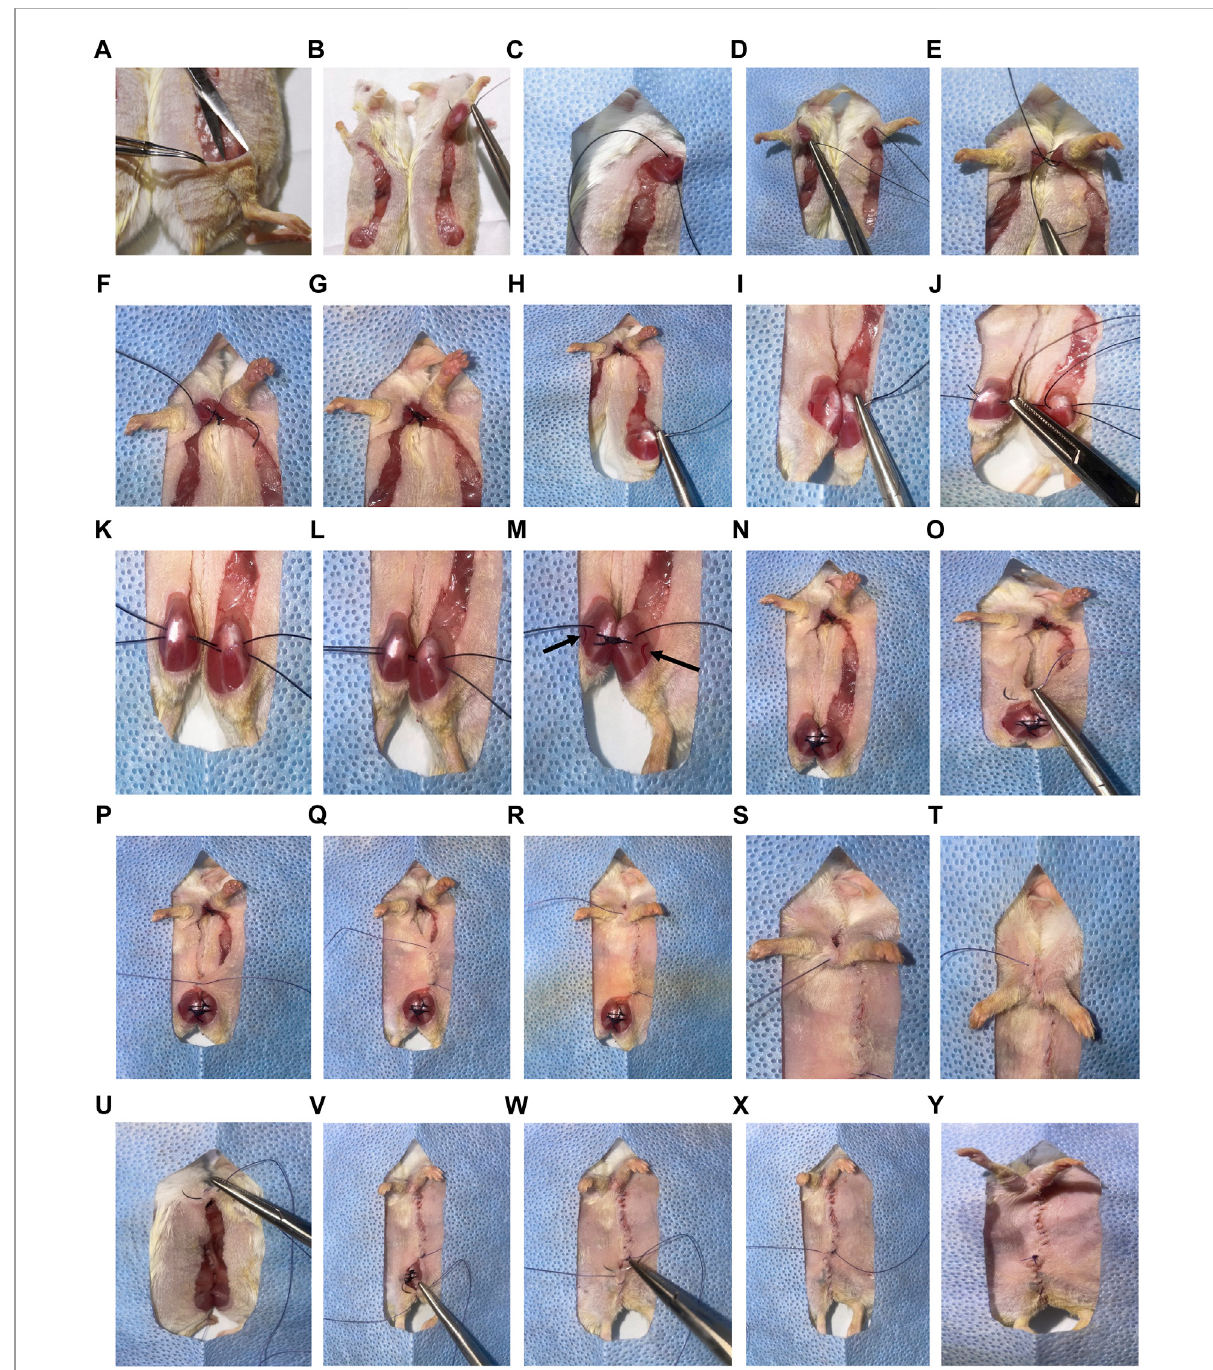
FIGURE 2 Overview of parabiosis surgery. (A) After generating the elbow to knee incision site, use non-toothed forceps to gently pinch and lift the top layerofskin atthekneejointarea. Insert thetipofscissorsunderneath theskinand openthescissors,creating apocket. (B) Use3-0non-absorbable suturestoattachtheelbowofoneparabionttotheelbowoftheotherparabiont. (C) Passtheneedleabovetheolecranonjointbybendingtheelbow of the fi rst mouse and pulling the suture through. (D) Bend the elbow of the second mouse, passing the same needle and suture under the elbow.Pullthesuturethrough,leavingasmalltail(5 cm). (E) Securethejointsandsutureswithasurgeon ’ sknot,followedbytwosquareknots. (F) Cut the ends short (less than 0.5 cm) leaving only suf fi cient length to prevent knot separation. (F,G) Repeat this step to create a second reinforcing ligature at the elbow. (H) Use 3-0 non-absorbable sutures to attach the knee of one parabiont to the knee of the other. Insert the needle medially under the knee joint and move the needle laterally under the joint. (I – K) Once the suture is pulled through one knee, continue to the other knee by inserting the needle laterally under the joint, and move the needle medially. Cut the suture leaving a 5 cm tail on each side with space between the